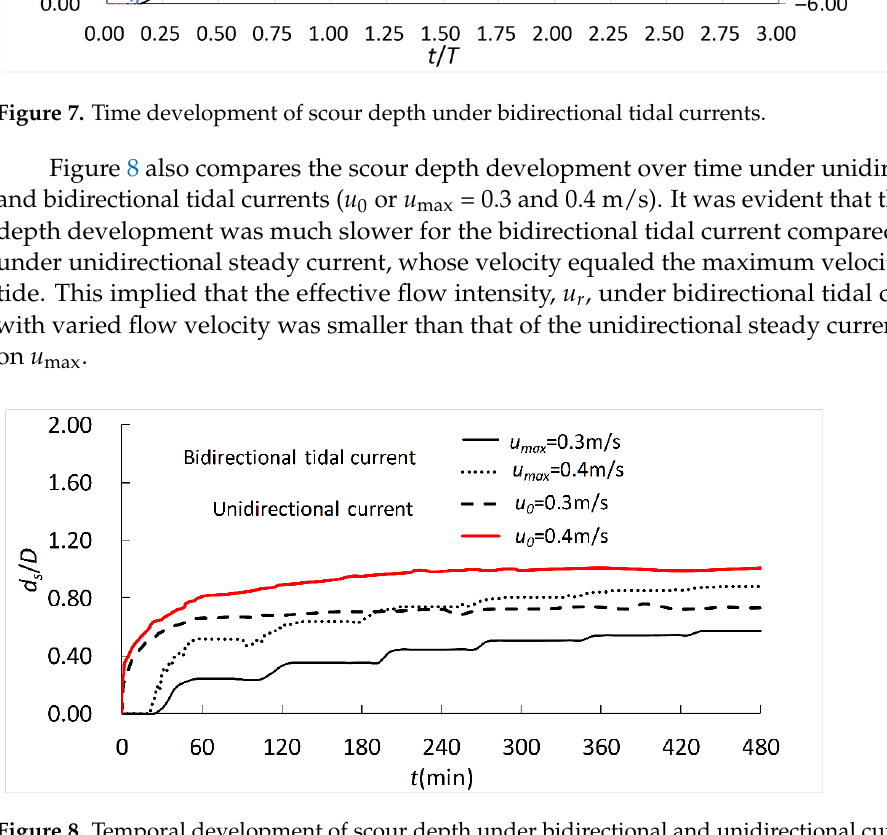
Figure 8. Temporal development of scour depth under bidirectional and unidirectional currents.